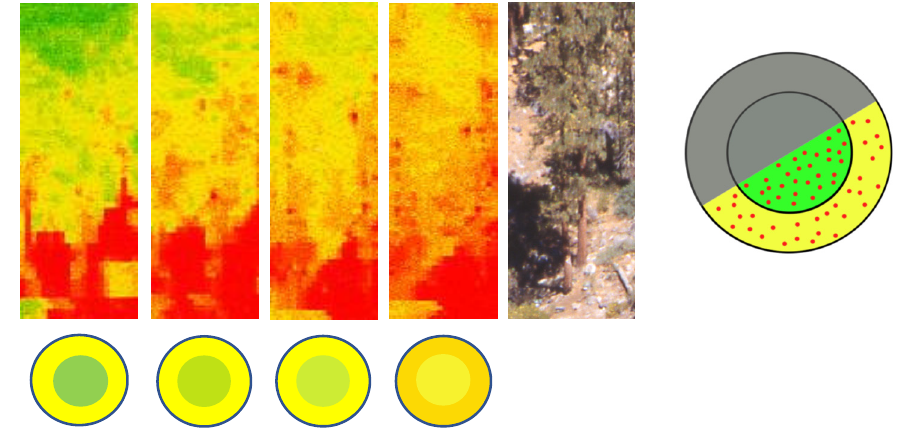
Figure 2. Thermal imagery of two Jeffrey pine trees taken at 0.5 h time steps, 1030 to 1200 (left) and true color (center right). Below imagery, a cartoon of an aerial view depicting the upper canopy (center circle) and the upper portion of the mid canopy (concentric circle), varying from cool (green, transpiring) to warm (yellow, stomata closed). On the right is a diagram of the masked shaded crown, and subsample points for R, NIR, and THERM of the top- and upper mid-crown. Points randomly occurring in the outer 2.2 m were rejected to avoid contamination by ground cover through the edge of the crown.